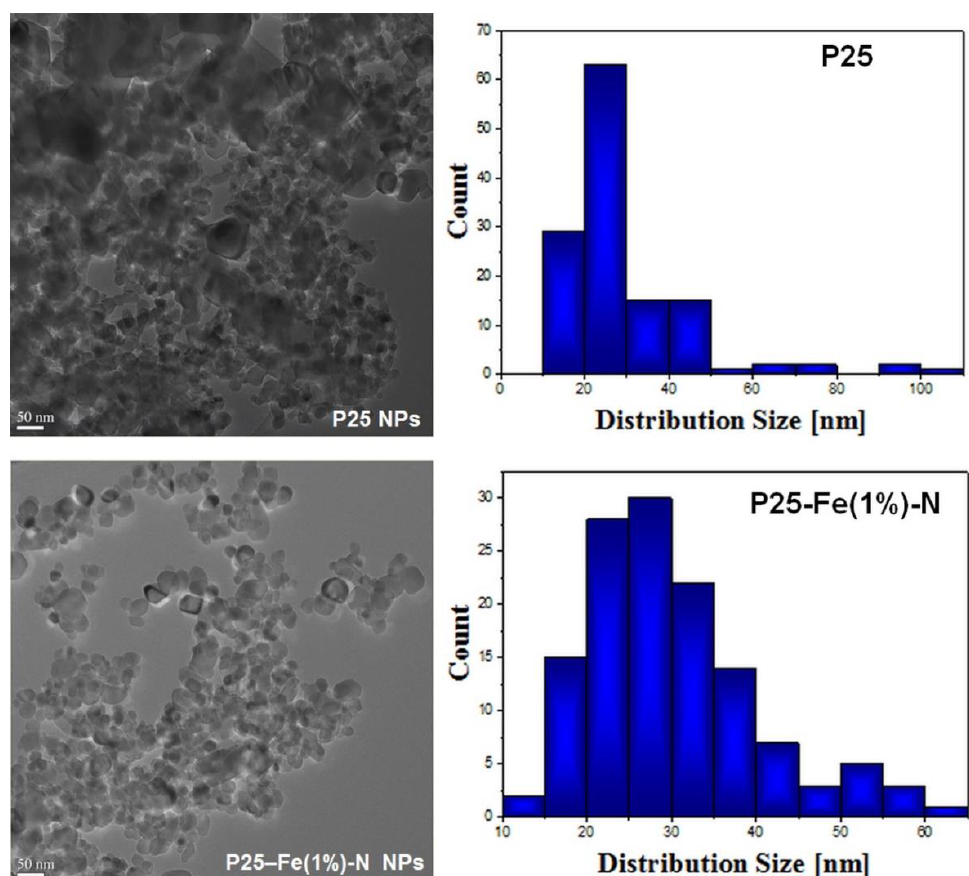
Figure 2. Transmission electron microscopy (TEM) images and particle distribution diagrams of the P25 and P25 – Fe(1%)-N NPs samples. P25 and P25–Fe(1%)-N NPs